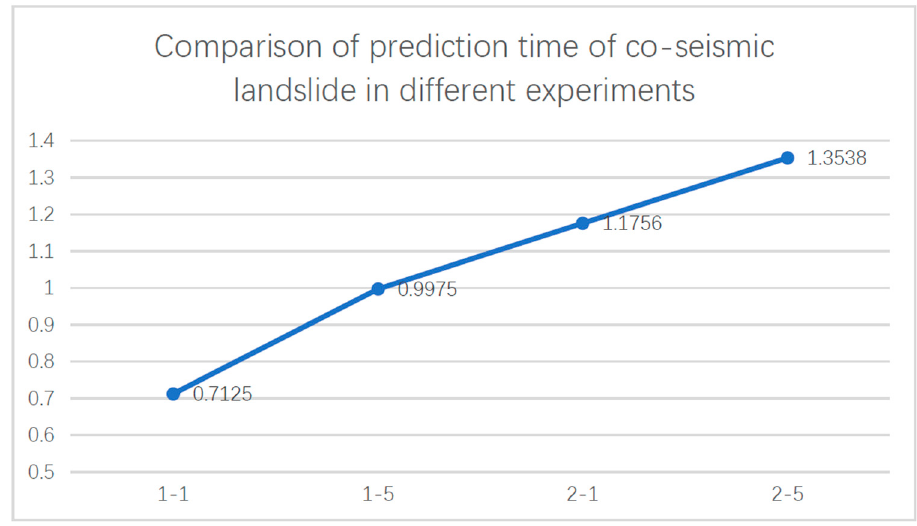
Figure 13. Comparison results of U-Net and DeepLab V3+ models under six-feature input.